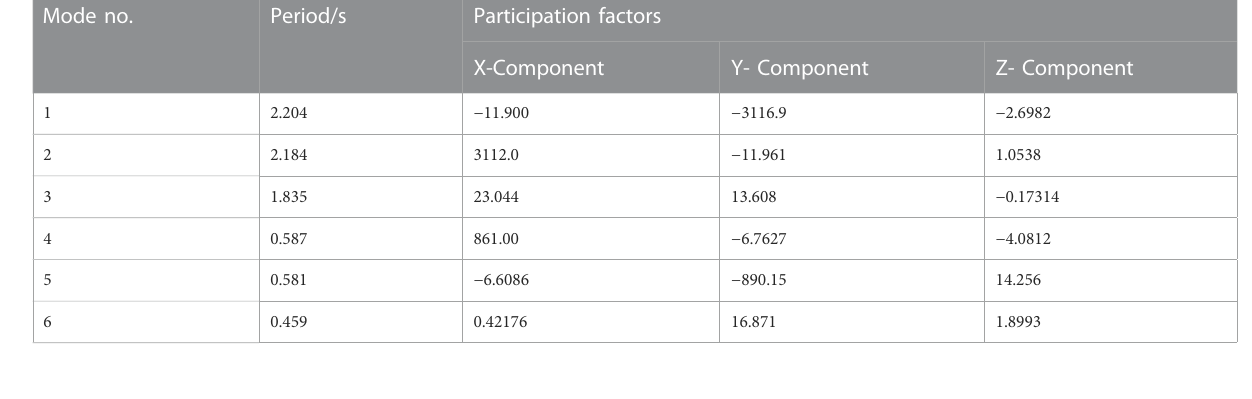
TABLE 2 Structural Modal periods and modal participation factors. Mode no.